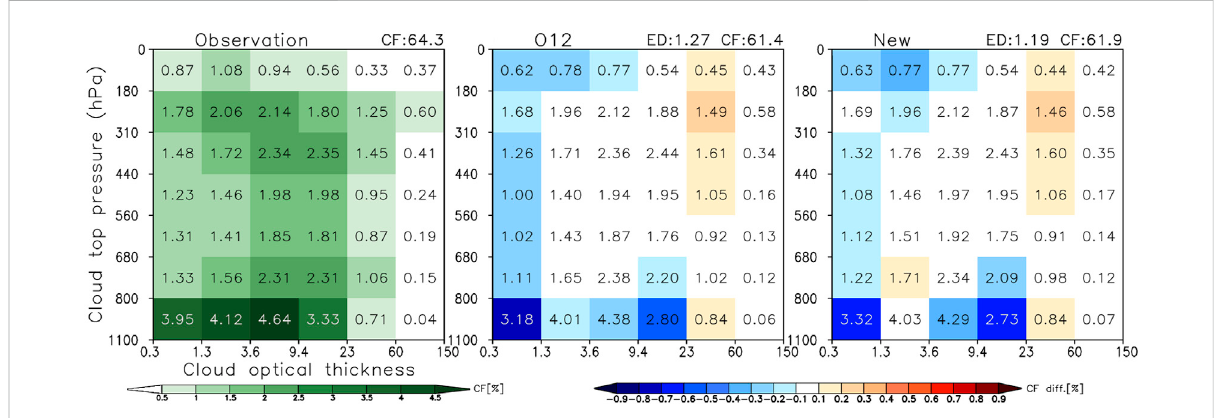
FIGURE 11 Grand-averageofCTP-TAUoceanicCF histograms from observations(O22COD fi lled,left panel), simulated with theRaisanensimulator using the decorrelation length Gaussian fi ts of O12 (middle panel) and the new Gaussian fi ts of this paper (Figures 3, 6) (right panel).